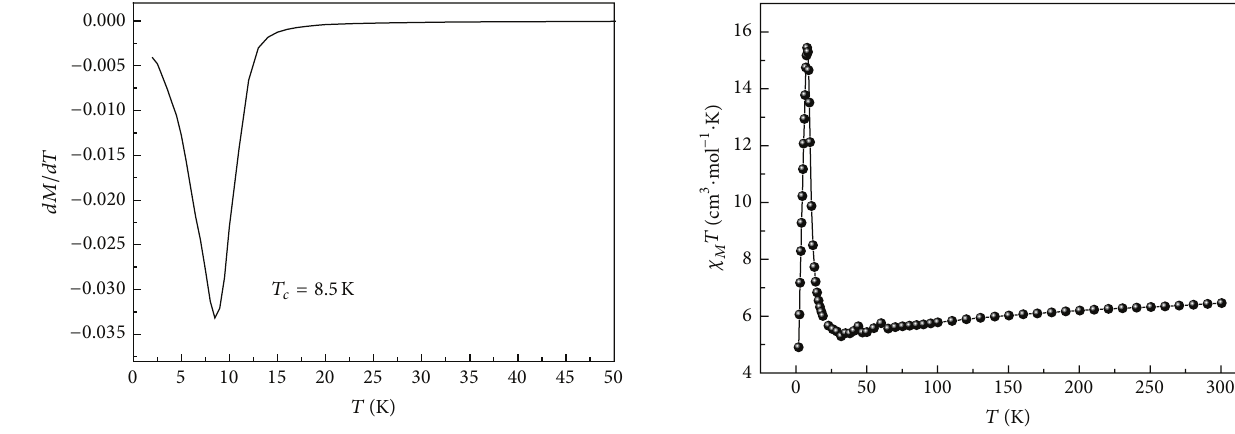
Figure 4: 𝑑𝑀/𝑑𝑇 versus 𝑇 for the compound.